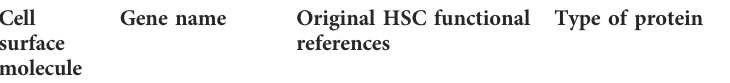
TABLE 1 Key haematopoietic stem cell markers, protein type and functional